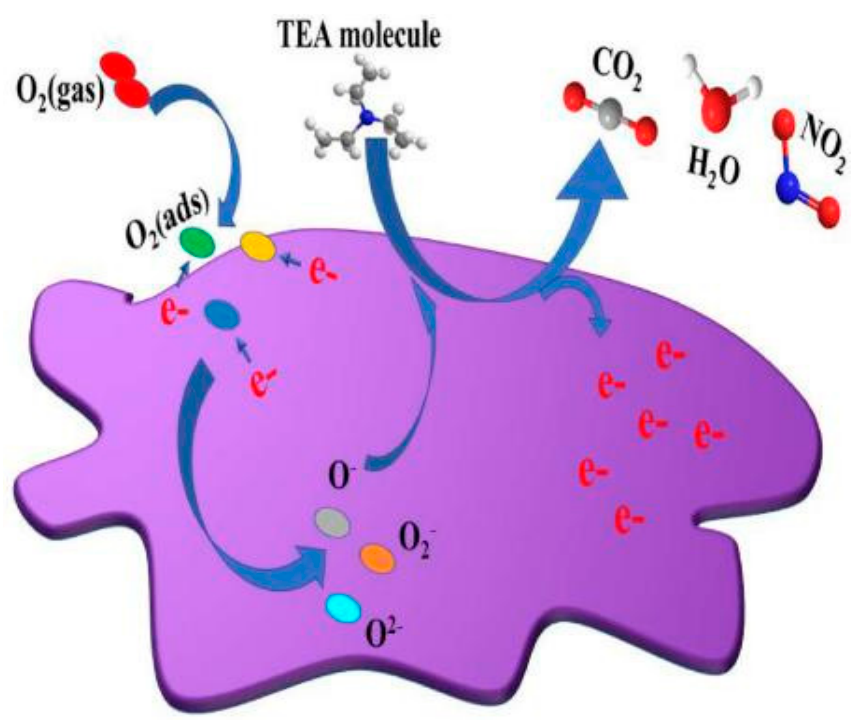
Figure 2. One typical n-type gas-sensing mechanism for an SnWO 4 sensor exposed to air and TEA gas [41].